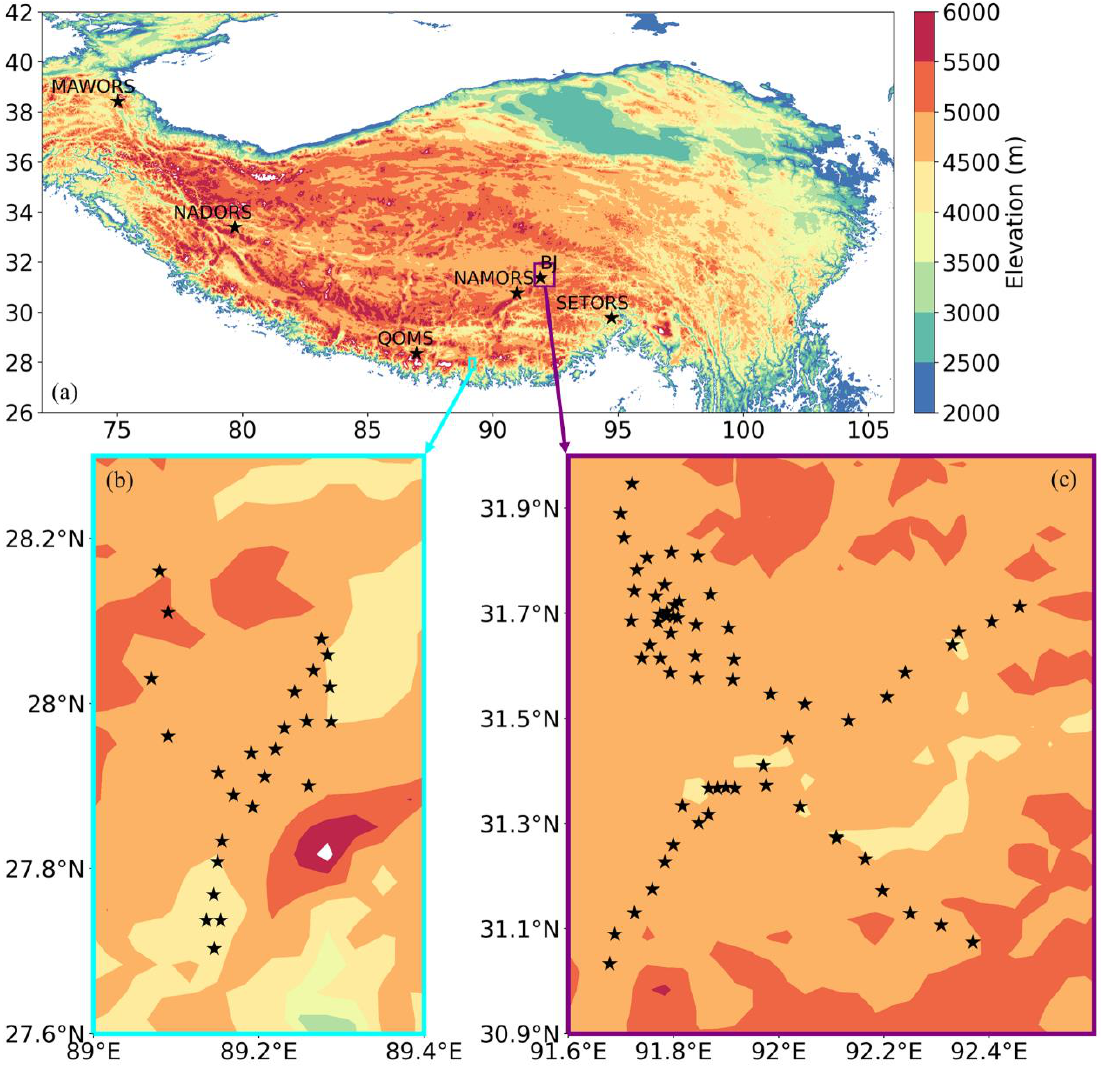
Figure 1. Distribution of field observation stations: ( a ) TP, ( b ) Pali, and ( c ) Naqu. The contour color represents different elevations. Pentagrams represent the station locations.